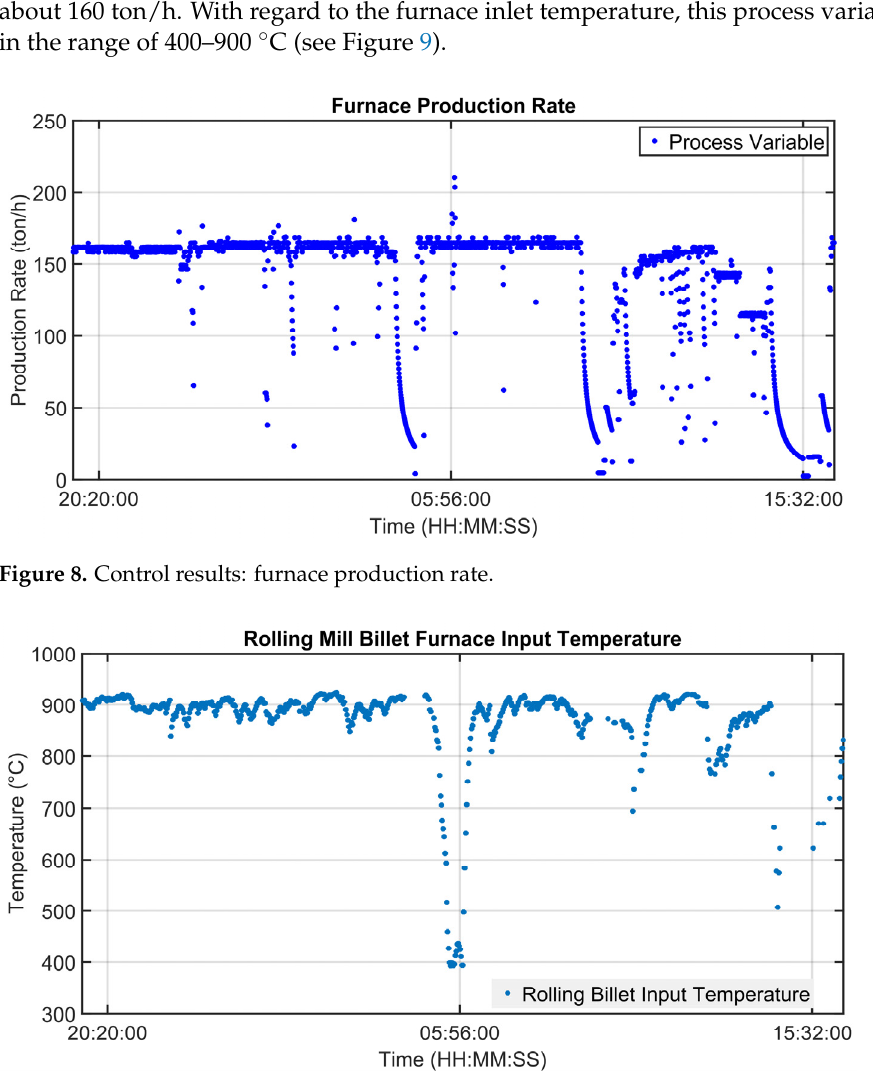
Figure 10. Control results: billets temperature at rolling mill pyrometer.